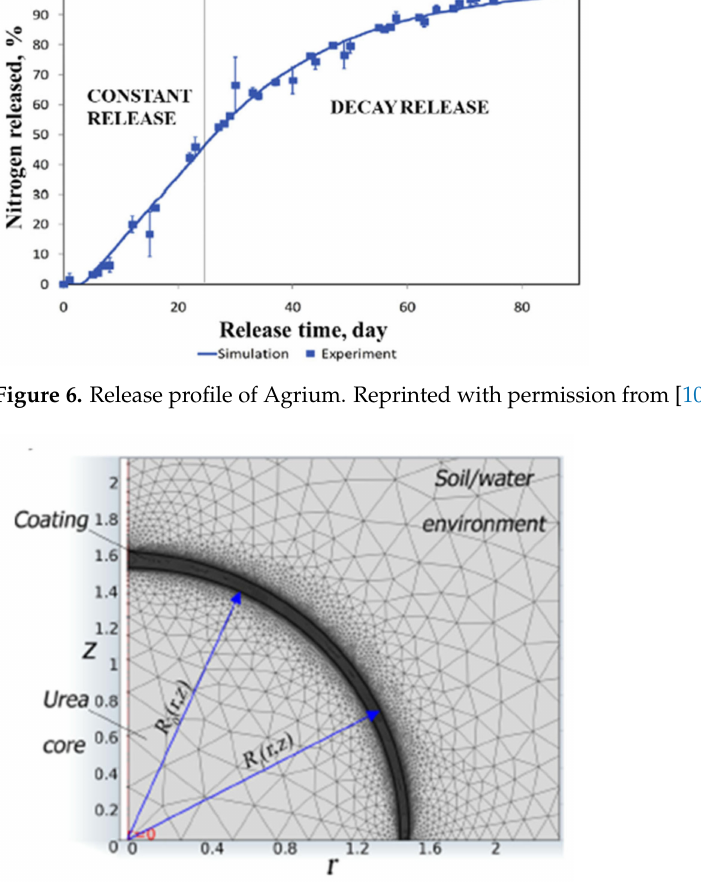
Figure 7. Geometry and Mesh Generation of urea core and its environment. Reprinted with permis- sion from [110]. Copyright 2015 American Chemical